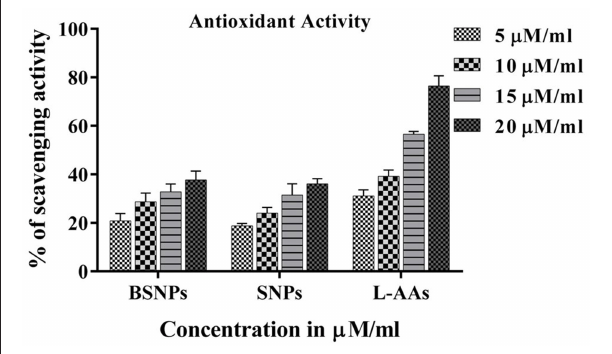
FIGURE 4 | The scavenging potential data of biogenic silver nanoparticles (BSNPs) and chemically synthesized silver nanoparticles (SNPs). The values demonstrate the mean ± standard error mean (SEM) % scavenging activity of the compounds using L-ascorbic acid (Standard). Experiments were performed in triplicates, the error bar represents statistically significant ( p < 0.05). TABLE 2 | Scavenging potential data of biogenic silver nanoparticles (BSNPs) and chemically silver nanoparticles (SNPs).